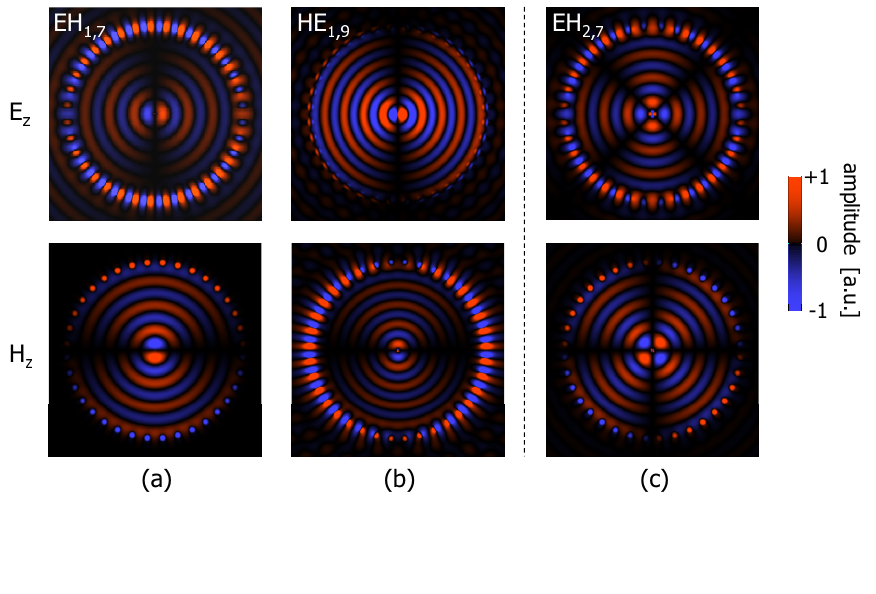
Figure 7. Mode field profiles of EH and HE modes. ( a ) EH detailed location on the dispersion relation, see Figure